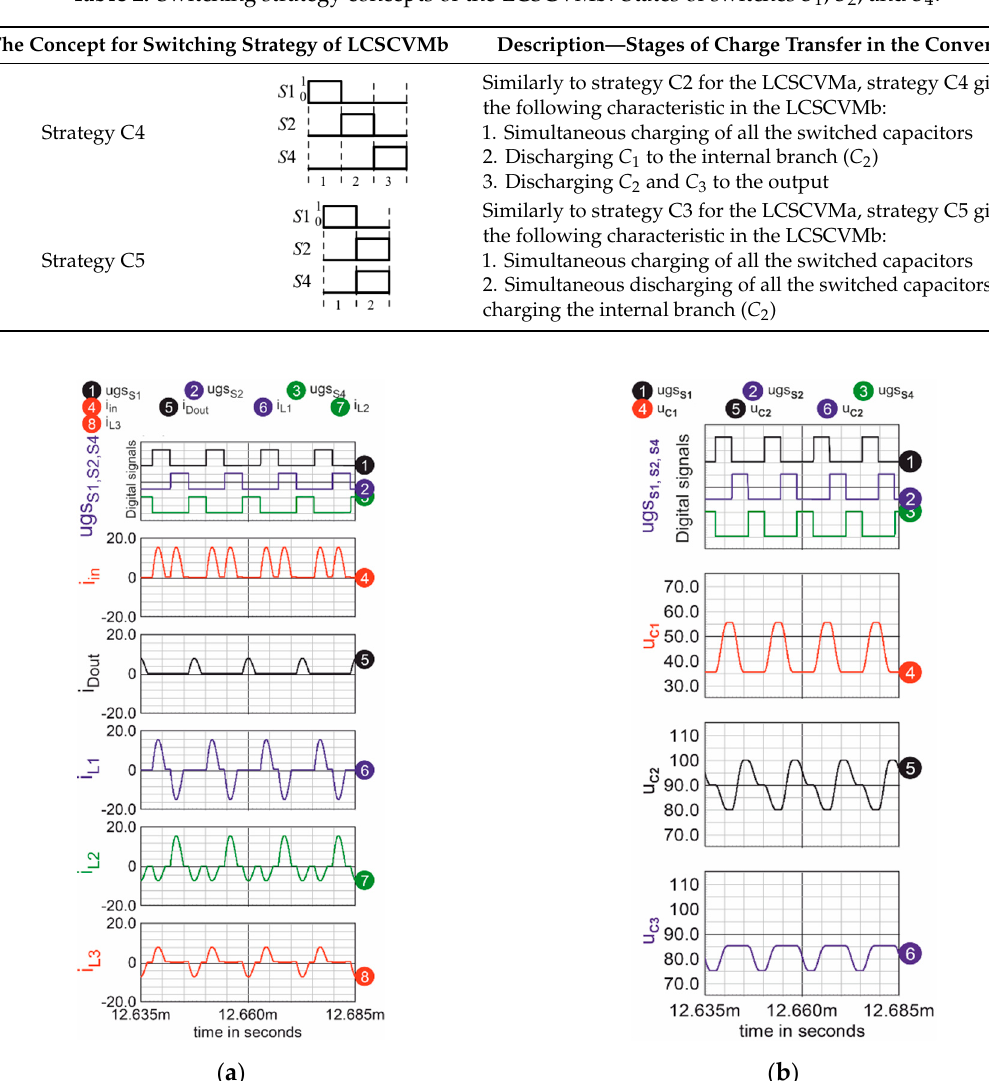
Table 2. Switching strategy concepts of the LCSCVMb. States of switches S 1 , S 2 , and S 4 .